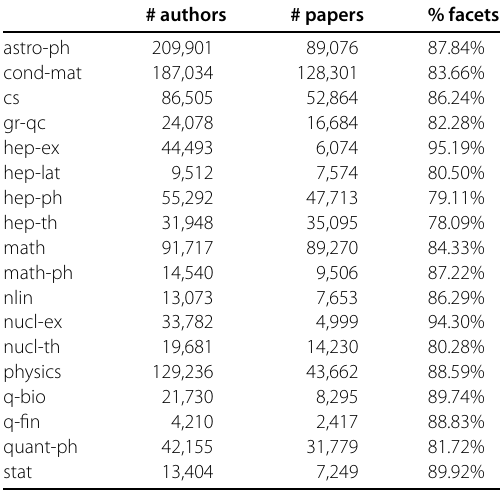
Table 1 arXiv statistics. For each category we show the number of authors, the number of papers and the percentage of the papers retained for the analysis # authors # papers % facets